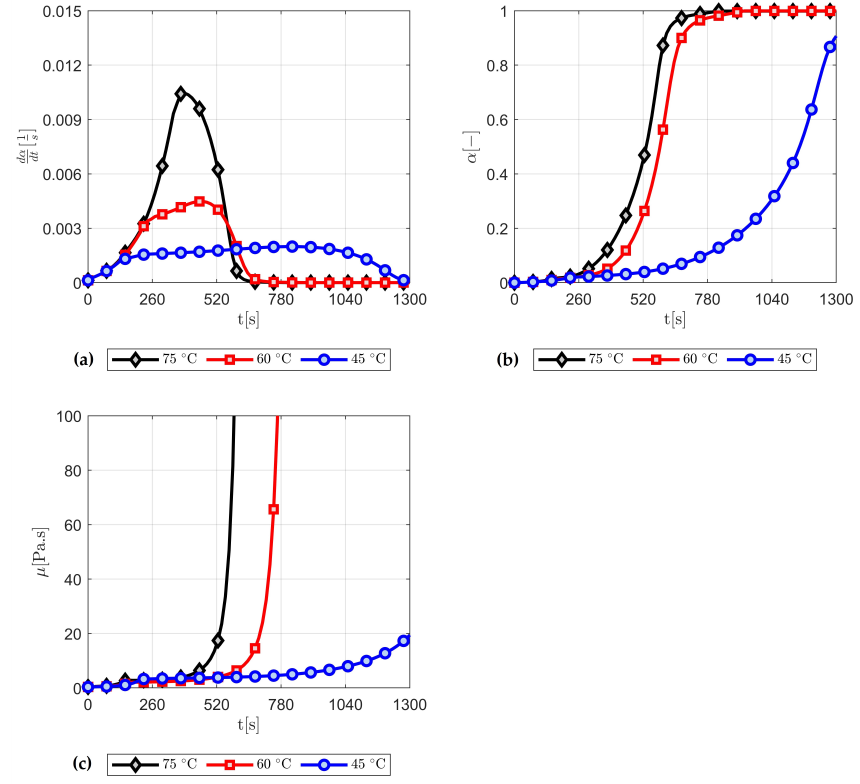
Figure 8. Numerical simulations of the reactive flows: ( a ) the rate of reaction; ( b ) degree of cure; and ( c ) viscosity